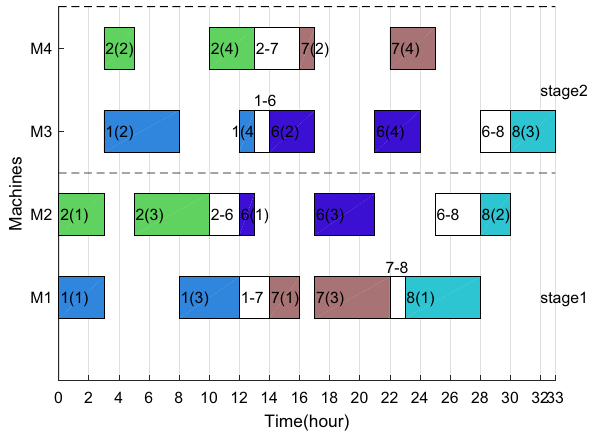
Figure 6. Gantt chart of factory1.